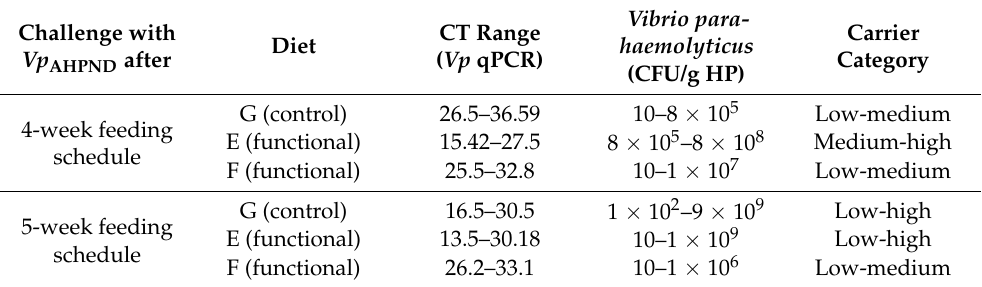
Table 6. Bacterial load in hepatopancreas (HP) of survivor shrimps after challenges with Vibrio parahaemolyticus ( Vp AHPND strain).